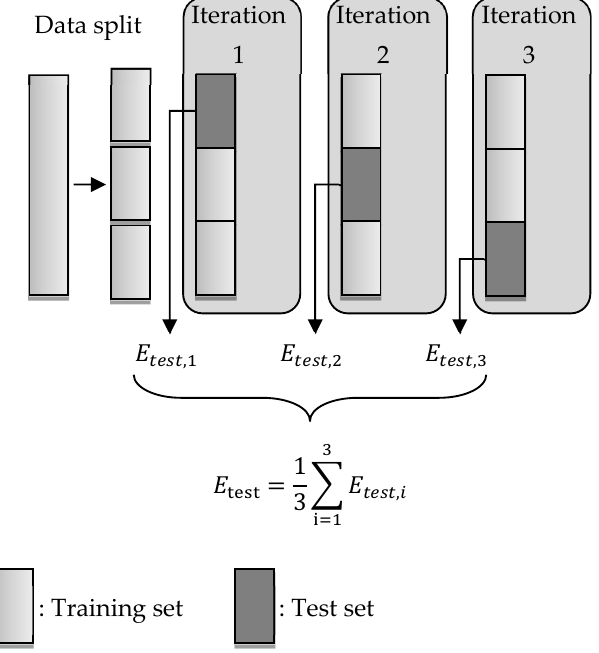
Figure 6. A k-fold cross-validation with 𝑘 = 3 .